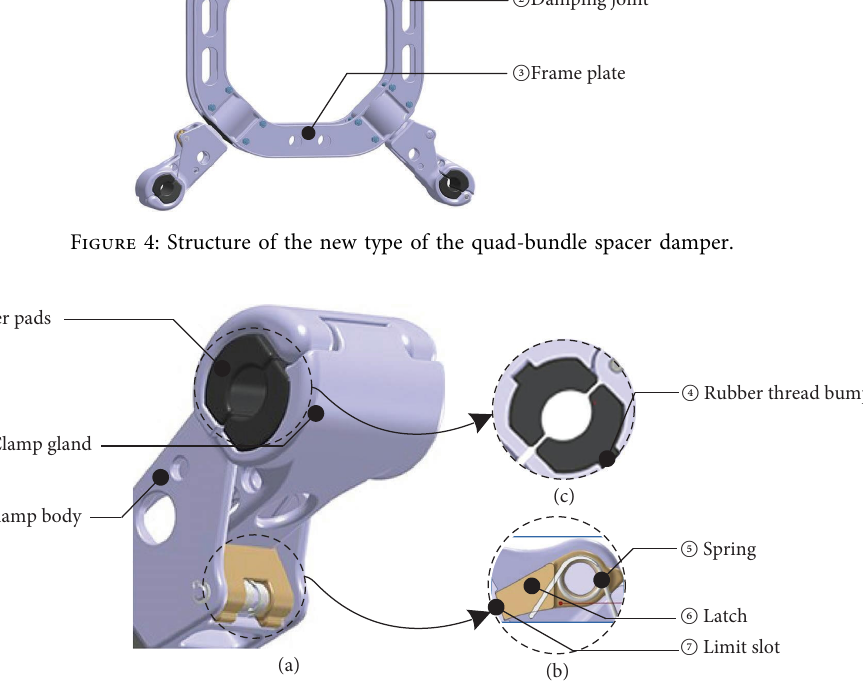
Figure 5: Clamp structure of the new quad-bundle spacer damper: (a) clamp component composition, (b) structure composition of clamp fxation part, and (c) rubber mat structure cross